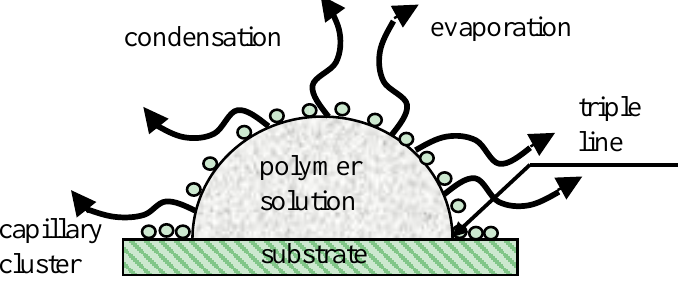
Figure 4. Breath-figure self-assembly taking place under drop casting is depicted. A droplet of the polymer solution is evaporated in the humid atmosphere. Water droplets are condensed at the polymer solution/vapor interface. A capillary cluster built from water droplets is formed in the vicinity of the triple (three-phase) line.